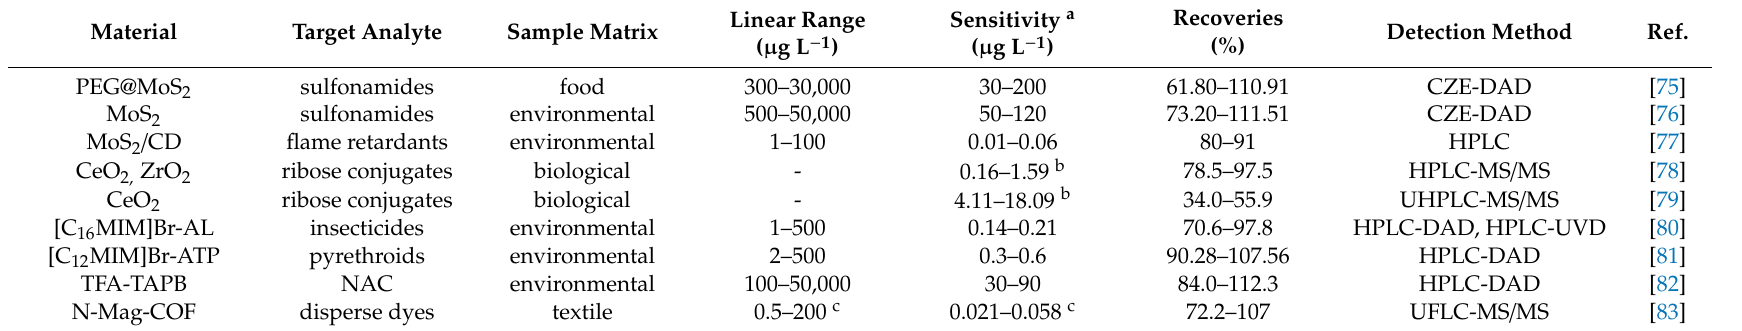
Table 8. Other notable